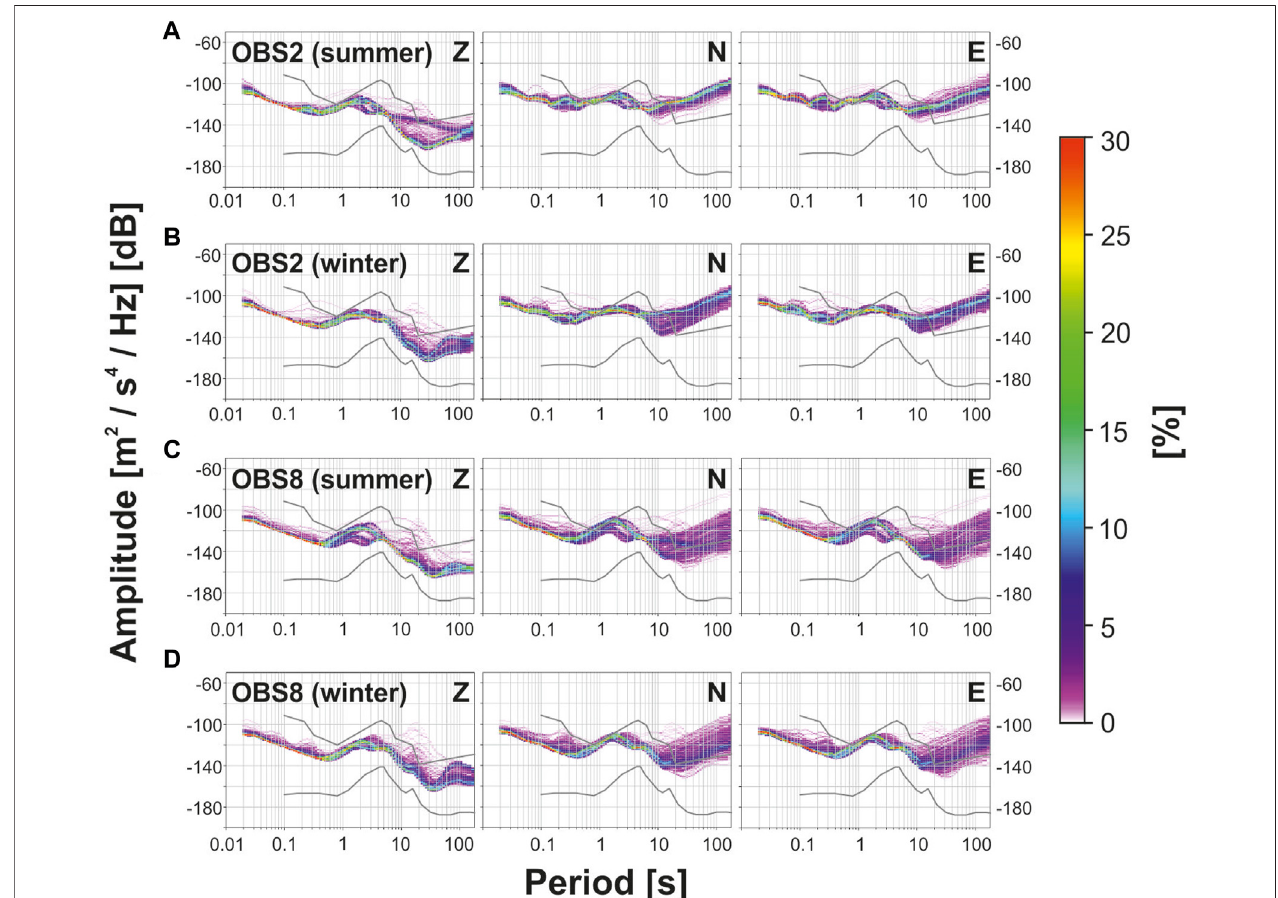
FIGURE 2 | Probability density function (PDF) for the three seismic components (Z, N, E), built during six days in two periods of the year (A) OBS2 during 2017, 11 – 16July(summer) and (B) 2018,25 – 30January(winter) (C) OBS8duringthesummerand (D) winterseasons.Theamplitudeisgiveninunitsofdecibels withrespect to acceleration (m 2 /s 4 /Hz). The colour bar represents the probability of occurrence of each PSD normalized from 0 to 30%.